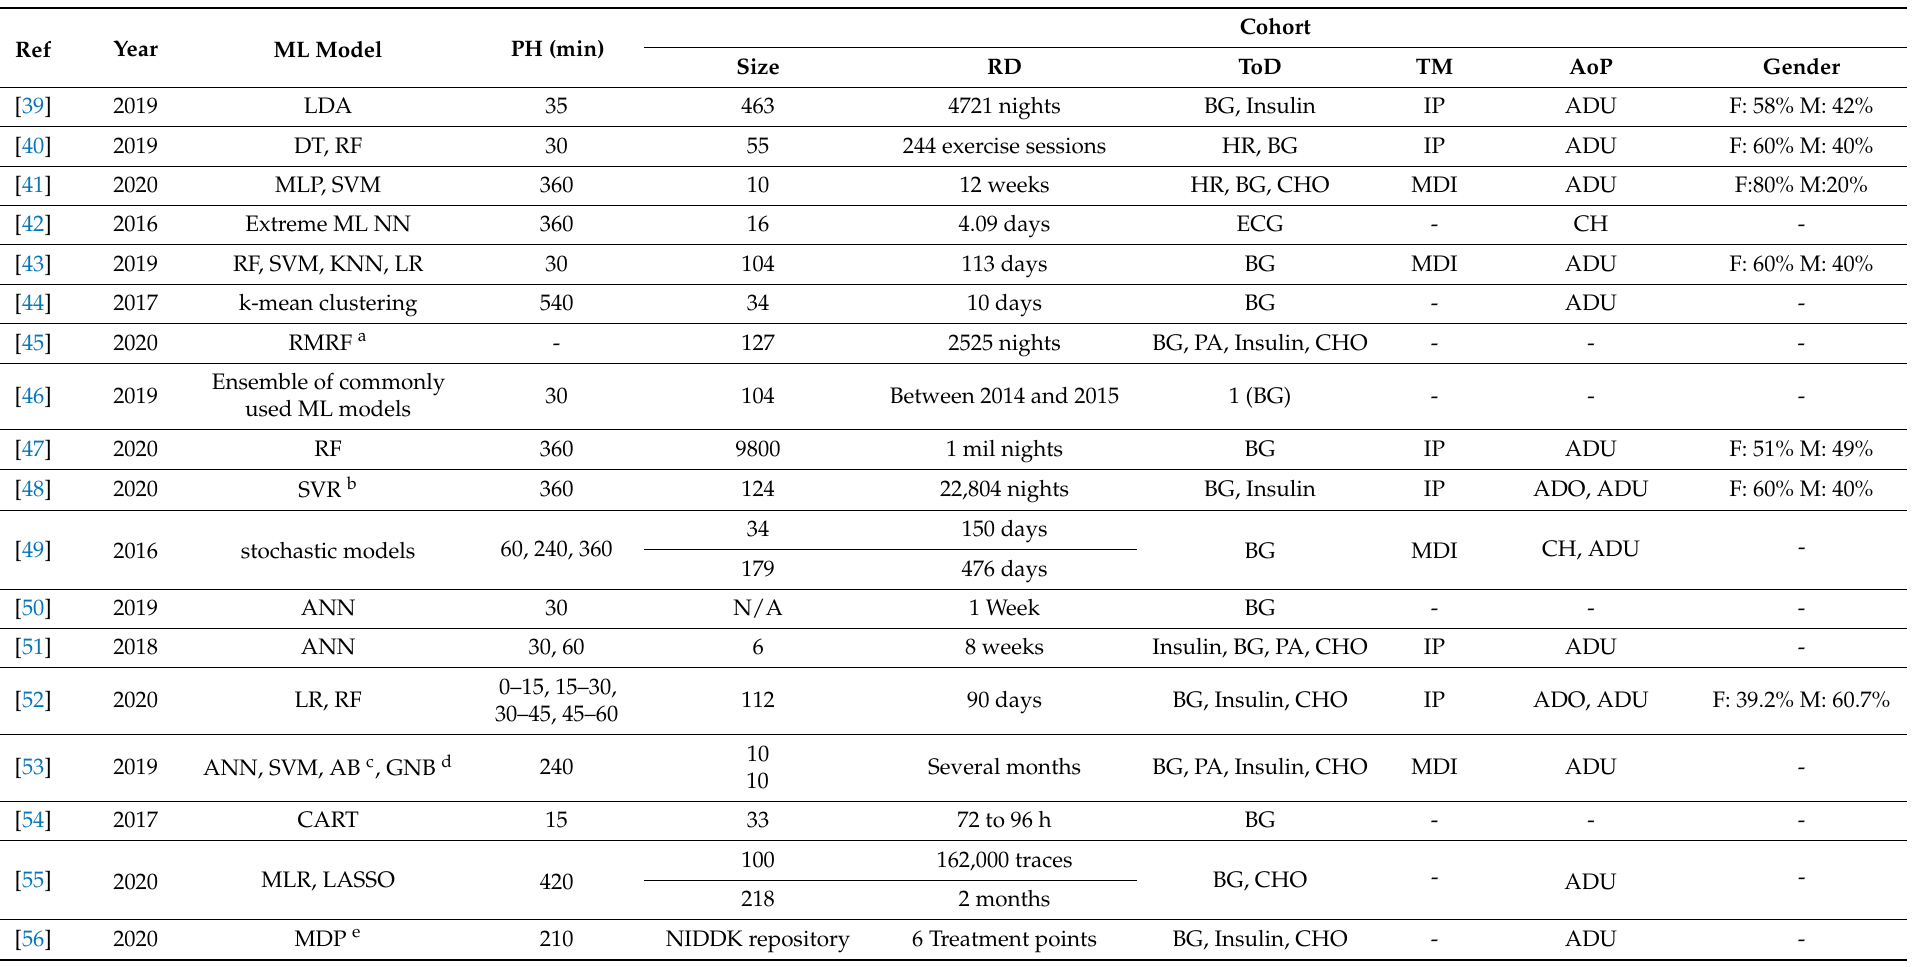
Table 2. Summary of reviewed manuscripts addressing hypoglycemia prediction: ML model used to perform the detection, prediction horizon (PH) in minutes, the size of the